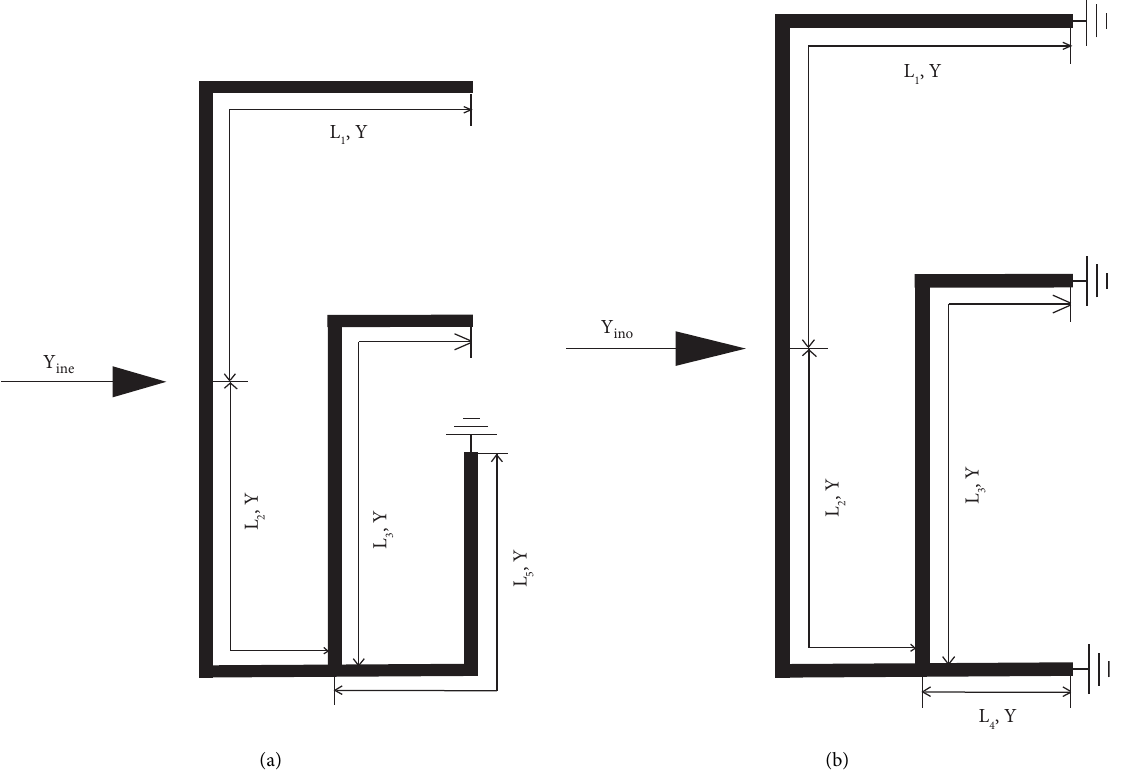
Figure 2: (a) Even-mode equivalent circuit. (b) Odd-mode equivalent circuit.